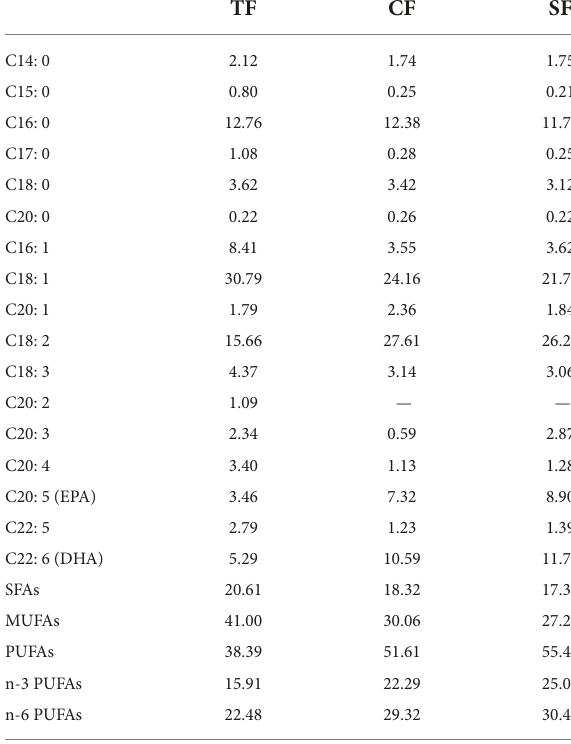
TABLE 2 Fatty acids composition of the experimental diets (percentage of fatty acids,